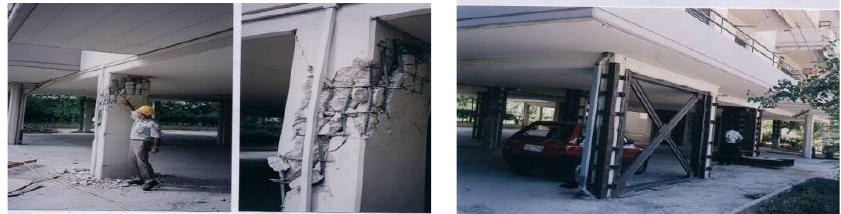
Figure 3. Damaged columns at the soft ‐ story and temporary steel shoring.